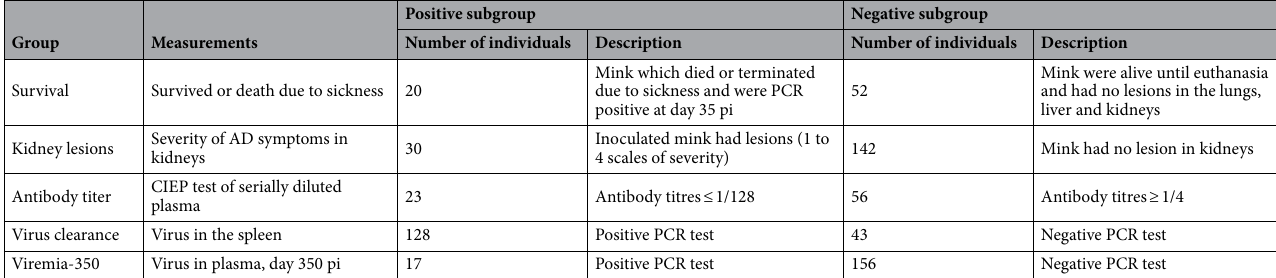
Table 1. The phenotypic traits used to classify individuals in five pairwise groups based on the response to AMDV